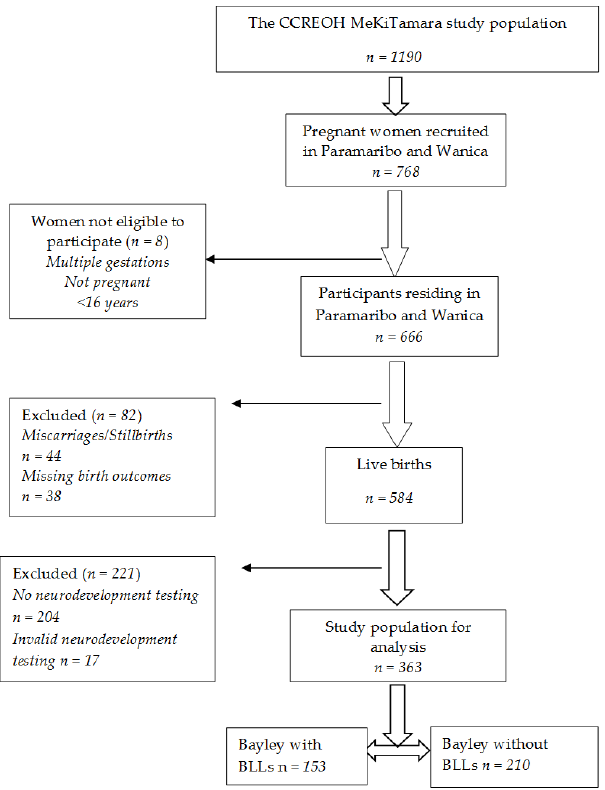
Figure 1. Flowchart of the study population (BLLs is blood lead levels).